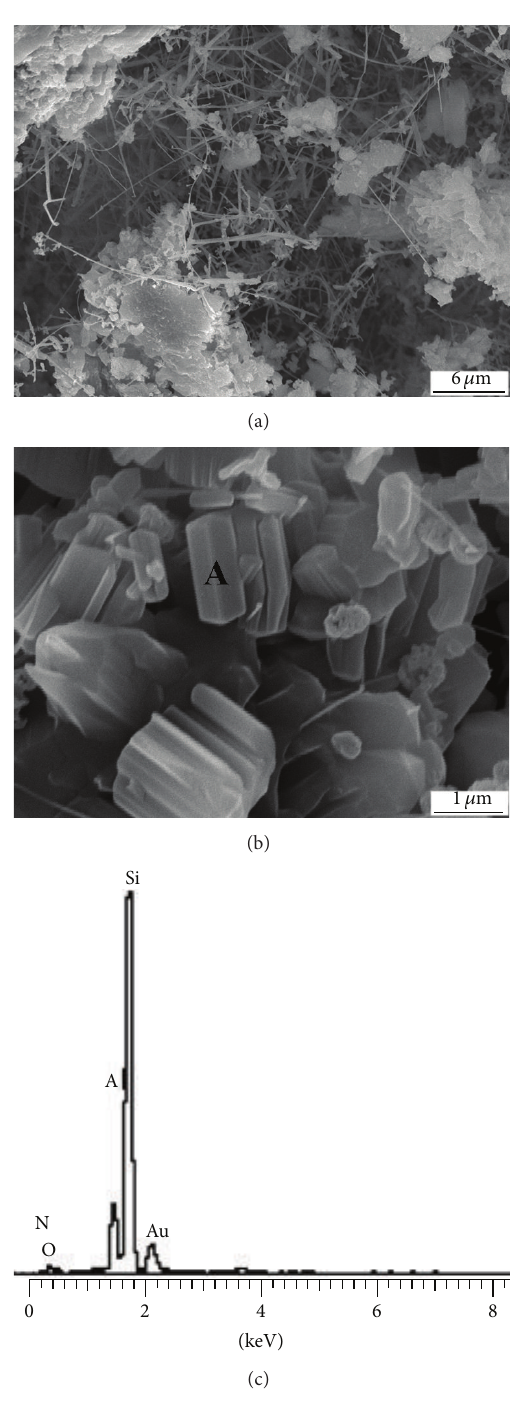
Figure 2: SEM photographs and EDS spectrum of samples: (a) sur- face fracture microstructure of sample M4; (b) surface microstruc- ture of sample M4; (c) EDS spectrum of point A in